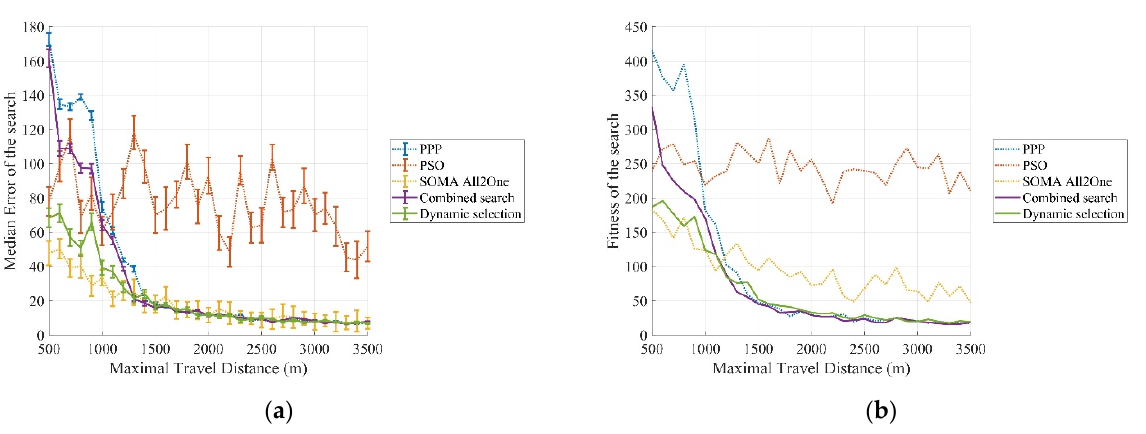
Figure 31. Performance comparison between different swarm composition strategies; all autonomous underwater vehicles (AUVs) utilise the same search strategy, static combination of pre-defined path planning (PPP) and particle swarm optimisation (PSO), and dynamic search strategy selection utilising fuzzy logic inference system (FIS); median of the error ( a ) and fitness ( b ) over maximal travel distance.